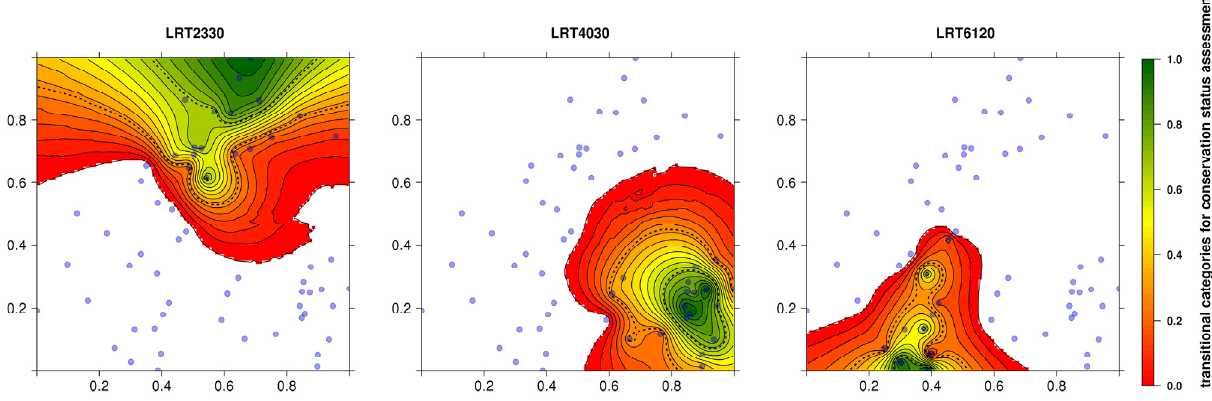
Figure 7. Probability for a Natura 2000 assessment of conservation status of three habitat types on an ordination plane. Equally spaced thresholds for assessment categories are shown by dotted